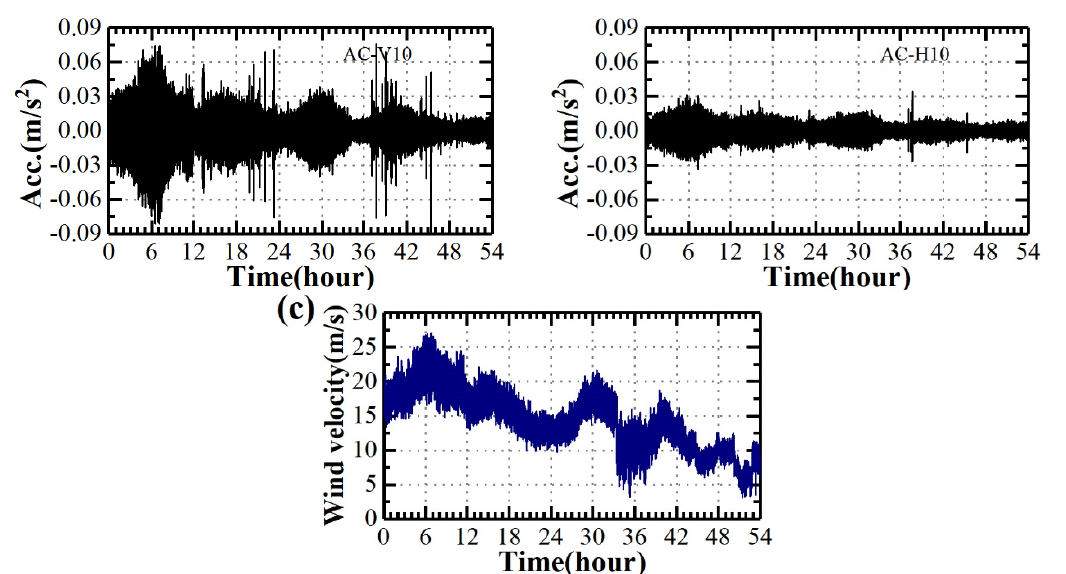
Figure 9. Time histories of accelerations of bridge girder and corresponding wind velocity: ( a ) Vertical acceleration; ( b ) Horizontal acceleration; ( c ) Wind velocity.